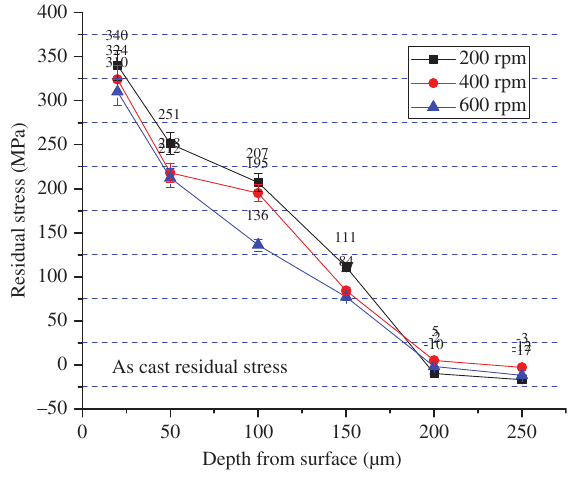
Figure 12: Residual stress vs. depth of penetration.